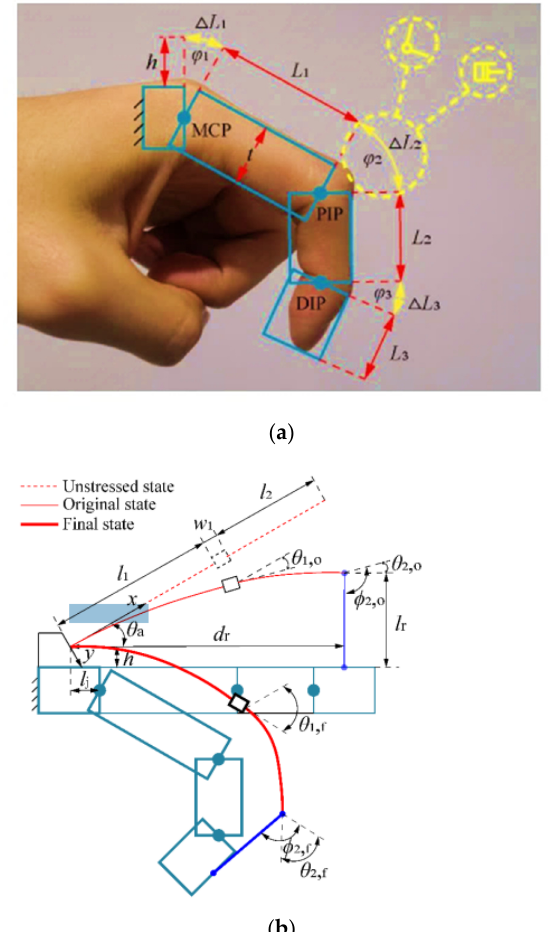
Figure 6. The base design principle for the hybrid-driven compliant hand exoskeleton [71]. ( a ) Basic design principle of the hand exoskeleton. ( b ) Human-machine coupling model based on human finger and the VSFH device. Here, l i represents the distance between the joints, l r is the length of the connecting rope from the VSFH device to the finger, d r is the horizontal distance between the connecting rope and fixed end of the VSFH device, θ a is the angle between the VSFH and the horizontal line, and w 1 represents the length of the connecting